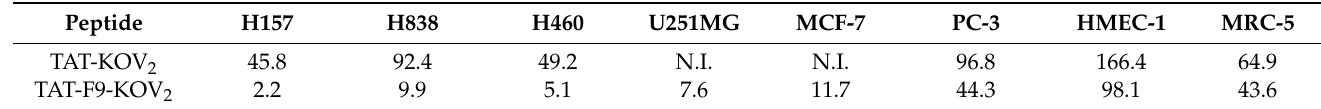
Table 5. The IC 50 value (µM) of TAT-KOV 2 and TAT-F9-KOV 2 against tested cell lines after 24 h of treatment.